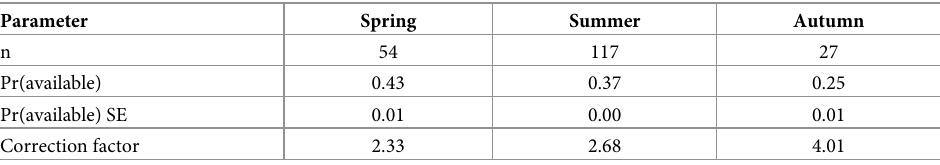
Table 2. Correction factors and their associated details by season.